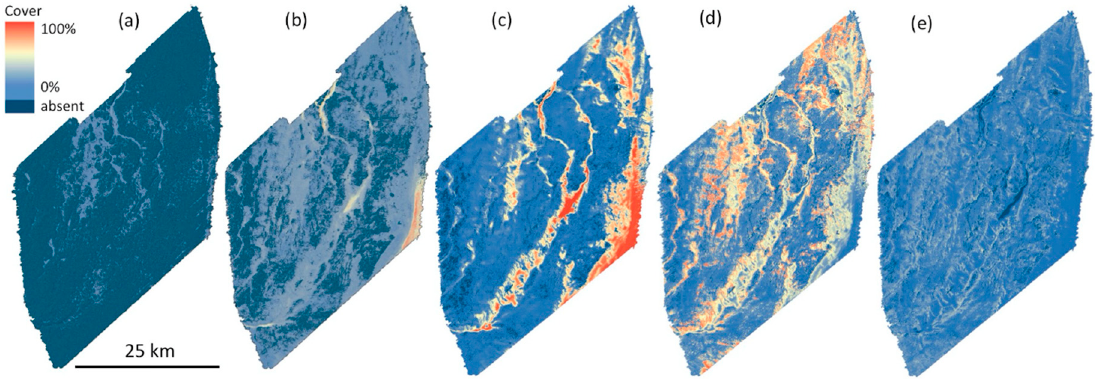
Figure 6. Coverage maps (%) of fine substrate components on Hoburgs Bank modeled from sieved grab samples, then adjusted to the main sand model. ( a ) Clay ( < 0.002 mm), ( b ) silt (0.002–0.06 mm), ( c ) fine sand (0.06–0.2 mm), ( d ) medium sand (0.2–0.6 mm), ( e ) coarse sand (0.2–2 mm)). For clay and silt the colors are stretched between 0-10% instead of 0-100%. Absence is based on modeled threshold ( < 0.01% cover). Table 11. Accuracy statistics (using bootstrap of training data, n = 25) for fine fraction proportions predicted from sieved sediment samples. R 2 , root mean square error (RMSE), mean absolute error (MAE).